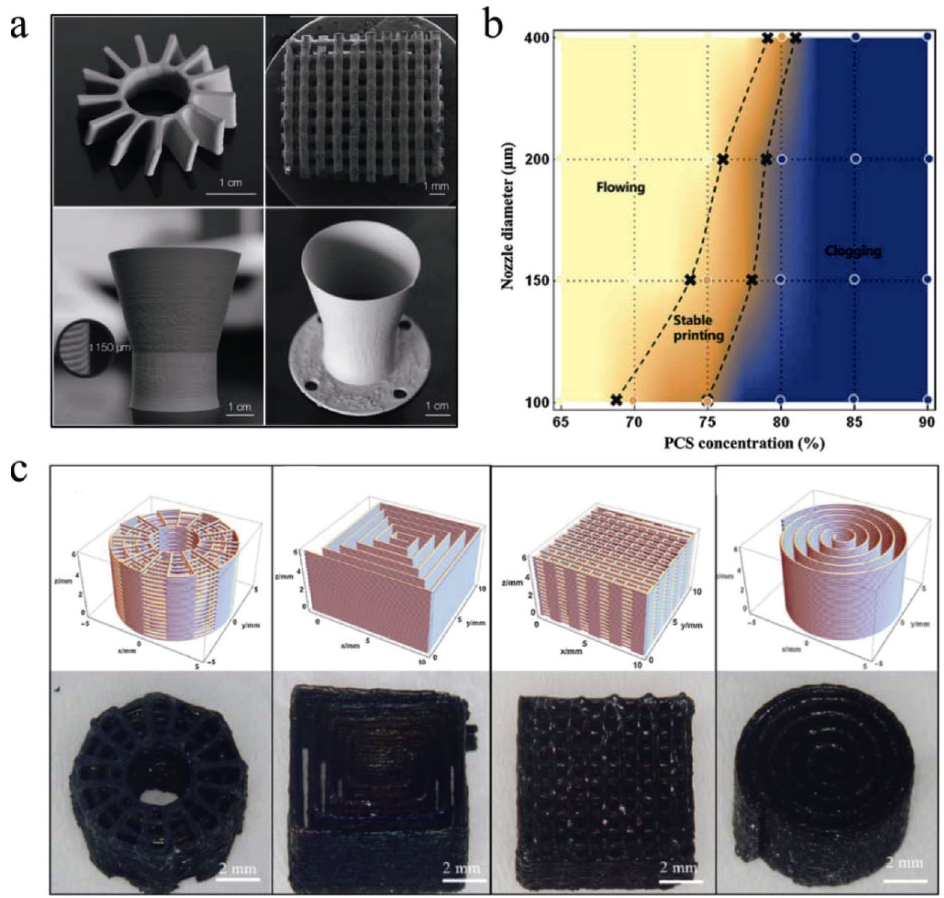
Fig. 33 DIW of SiC ceramic: (a) DIW of SiC ceramic. Reproduced with permission from Ref. [88], © WILEY-VCH Verlag GmbH & Co. KGaA, Weinheim 2015. (b) Writing-ability of ceramic ink; (c) DIW of polymer derived SiC ceramic. Reproduced with permission from Ref. [89], © Elsevier Ltd.